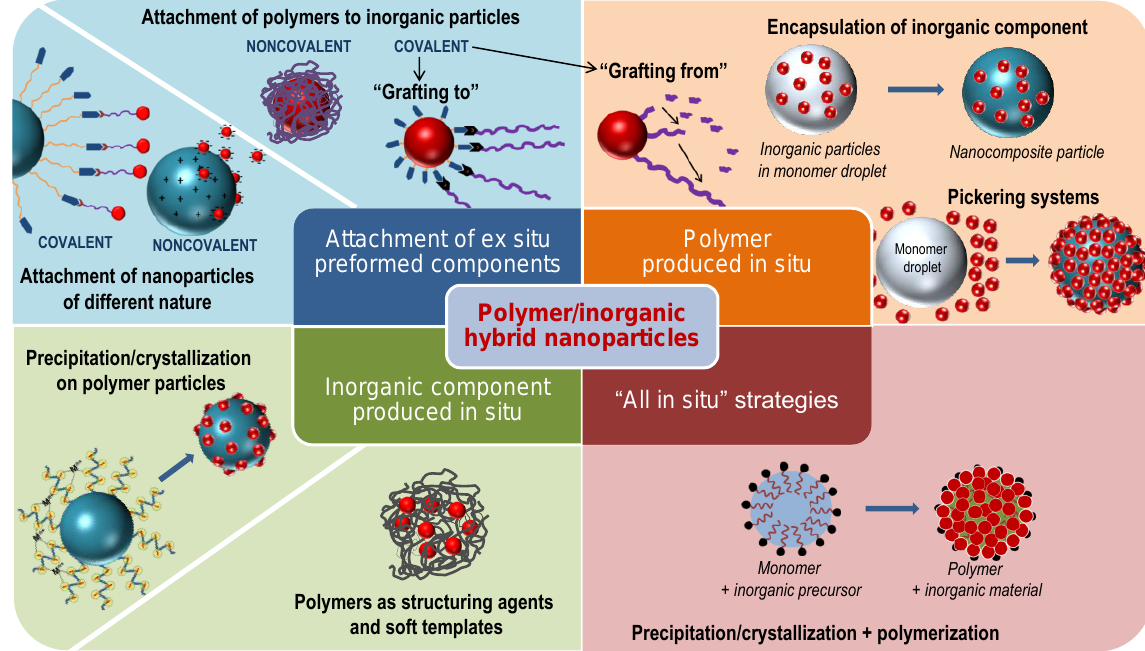
Figure 1. Different synthetic strategies in the formation of polymer/inorganic hybrid particles.